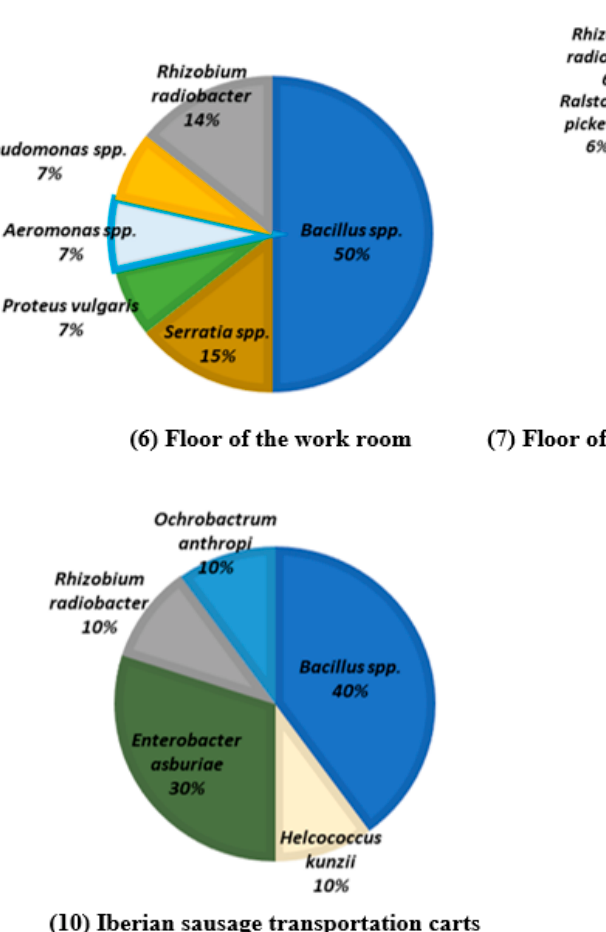
Figure 4. Individual profiles of the areas categorized as cluster 2. Bacillus spp. was predominant in all the areas and there was a marked presence of Rhizobium radiobacter and Enterobacter asburiae .